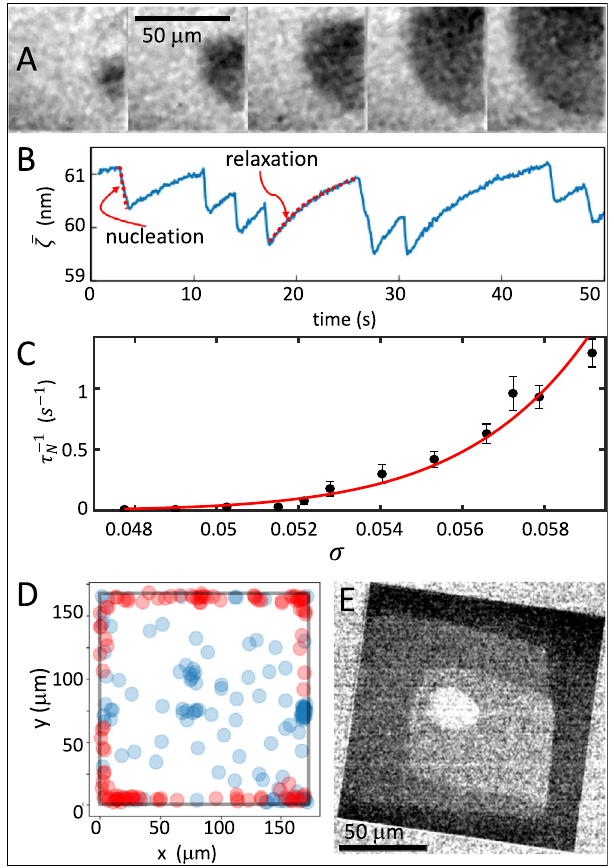
Fig. 2 | Nucleation of molecular layers. A Time series (0.1 s interval) of average subtractedRICMimagesofnucleationandspreadingofanewlayer(darkergray)at σ =0.051. B Temporal evolutionofmean distance, (cid:1) ζ , fora small crystal(L=48 μ m) showing sudden nucleation events (steep negative slopes of one unit cell height, 0.66nm) followed by a relaxation towards equilibrium distance. C Nucleation rate asfunction ofsupersaturation. The nucleationrate wasdeterminedbycountingof new layers in distance – time curves like( B ). The errorbars are standarddeviations. The red line isa fi t of nucleationtheorytothe data. D Localization of nucleation at differentsupersaturations.Positionofnucleationeventsat σ ≤ 0.051(blue)showing random, homogeneous nucleation and a weak tendency of heterogeneous nucleationatthreelocations,and σ >0.051(red)showingstronglocalizationatthe edge. E EnhancedRICMimagefromSupplementaryMovie2ofcrystalat (cid:1) ζ =53nm, σ =0.057 showing four molecular layers (different gray levels) with step fronts of height 0.33nm advancing inwards. Nucleation at the crystal edges and faster step front propagation in the vicinity of the crystal edge are caused by concentration gradients between the edges and the